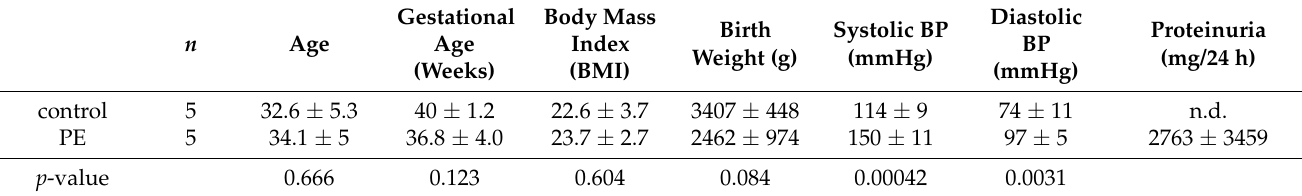
Table 5. Clinical information of preeclamptic patients and matched donors, whose placentas were used for primary trophoblast isolation (term). Mean value ± standard deviation is shown. BP, blood pressure; n.d., not